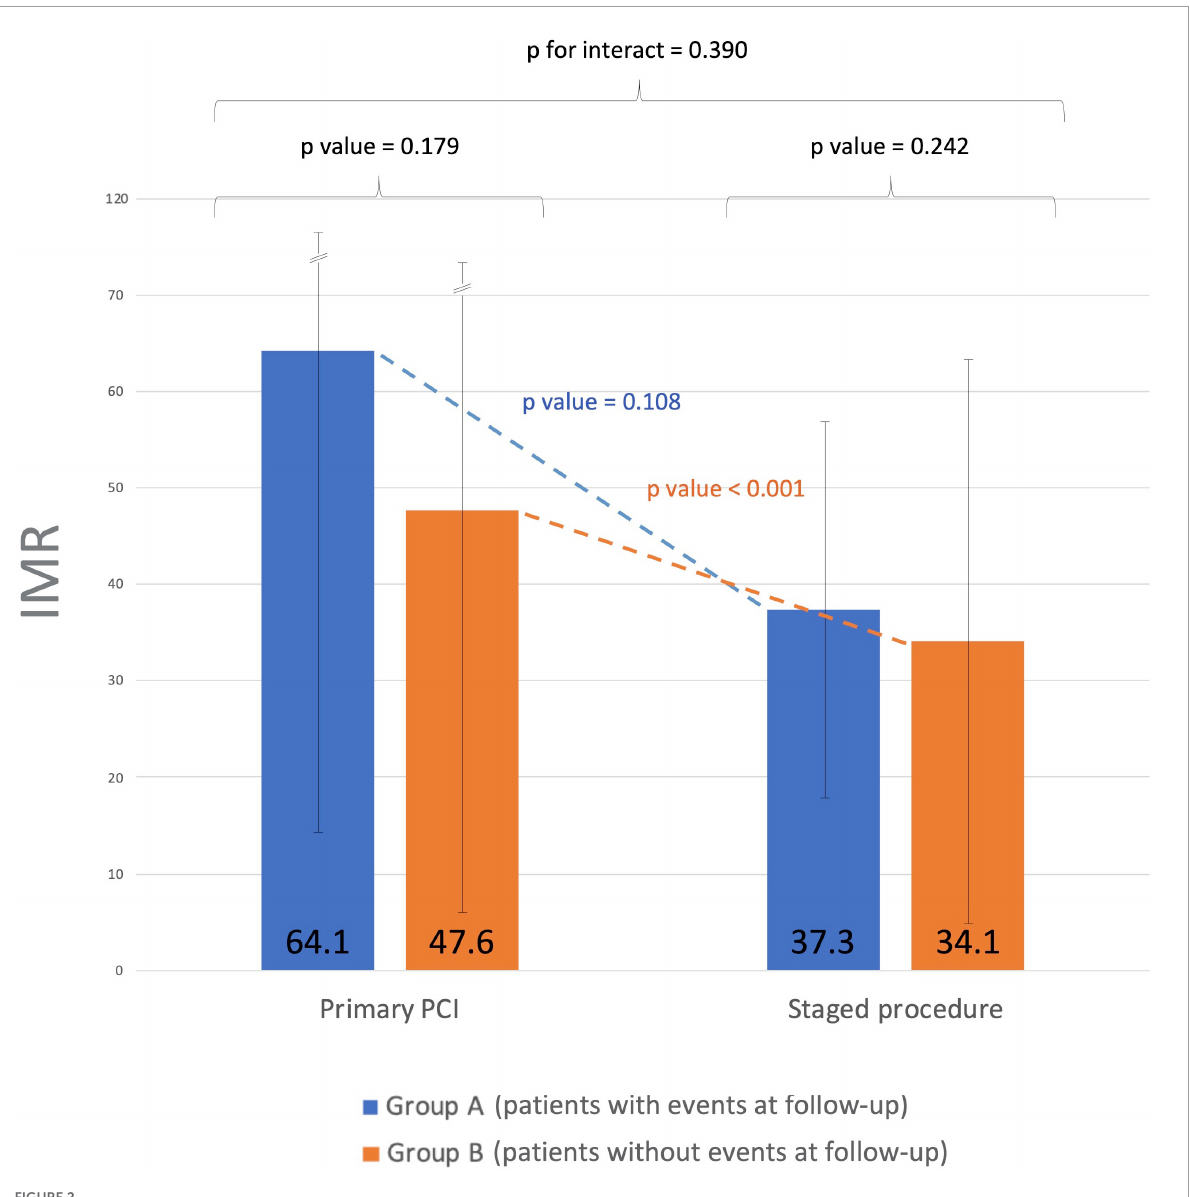
post-PPCI p = 0.279, IMR at staged procedure p = 0.99).